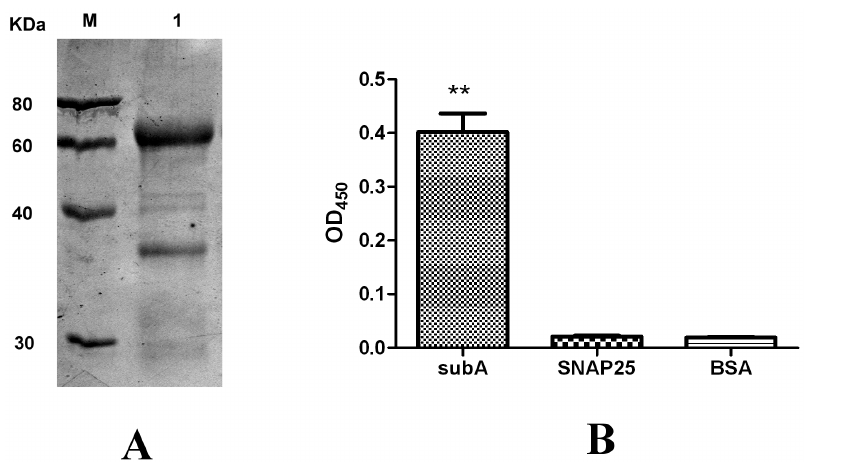
Figure 2. Purity and specificity analyses of purified anti-subA IgY. A) SDS-PAGE results of purified anti-subA IgY. M: protein molecular weight markers; Lane 1: purified IgY. B) ELISA result of Anti-subA IgY to subA, SNAP25, and BSA. *: notable statistical significance compared with BSA ( p , 0.01), # : no statistical significance compared with BSA ( p . 0.05).